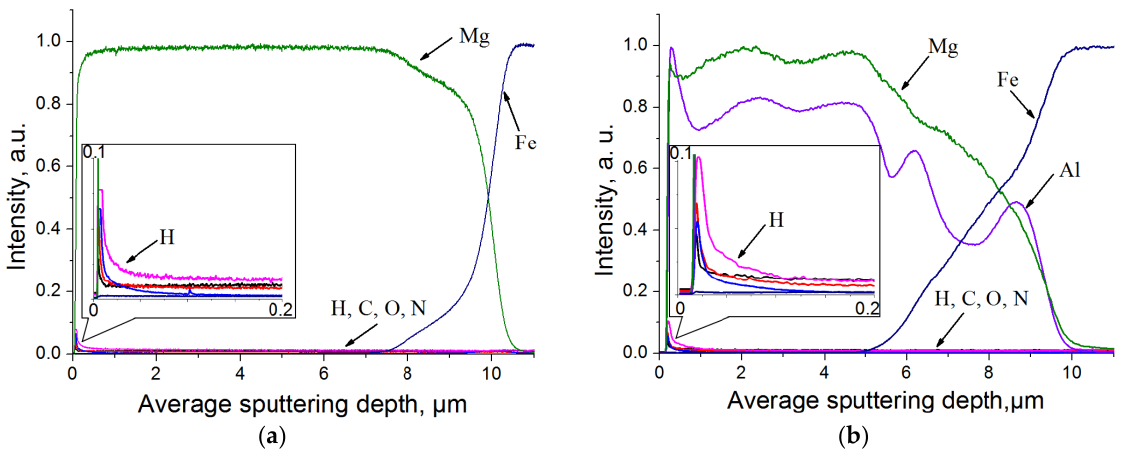
Figure 6. Depth distribution of chemical elements for samples with ( a ) Mg coating; ( b ) Mg-10%Al coating. The insets represent the hydrogen distribution in the coatings in more detail.